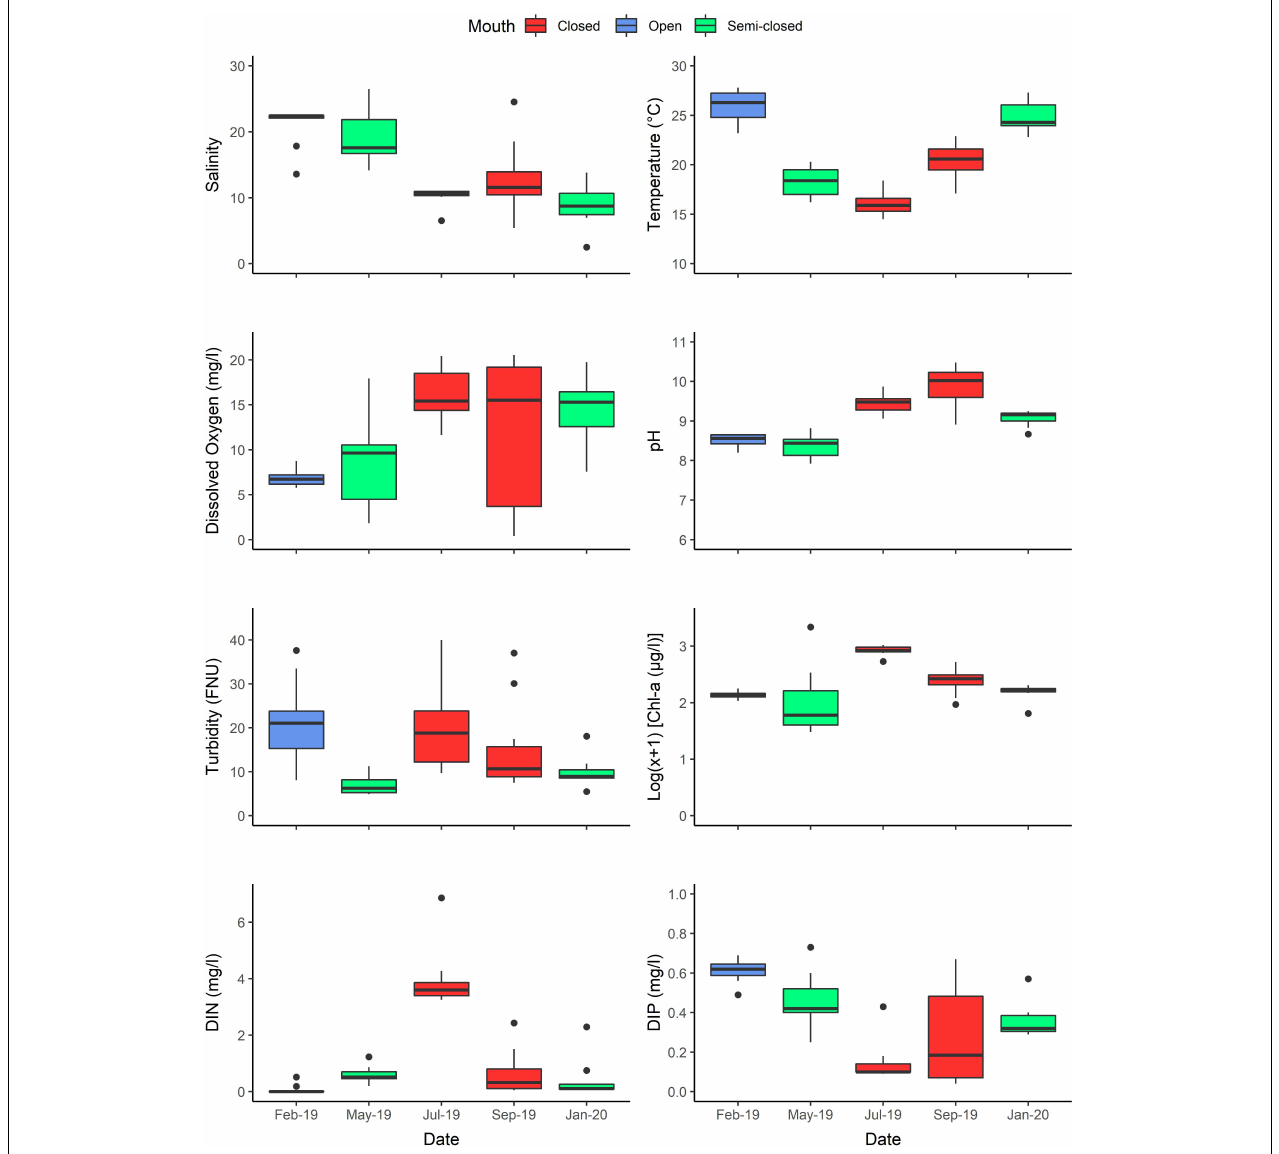
FIGURE 3 | Physico-chemical [salinity, water temperature, dissolved oxygen, pH, and turbidity (FNU)], inorganic nutrients [dissolved inorganic nitrogen (DIN) and phosphorus (DIP)] and phytoplankton biomass (chlorophyll- a ) variability recorded on each sampling occasion. The degree of estuary connectivity with the marine environment on each sampling date is indicated, i.e., open (blue), semi-closed (green), and closed (red) mouth conditions. Boxplots represent median values (solid line), interquartile range (IQR = 25th and 75th percentiles; box), ± 1.5 × IQR (whiskers), and outlier values.